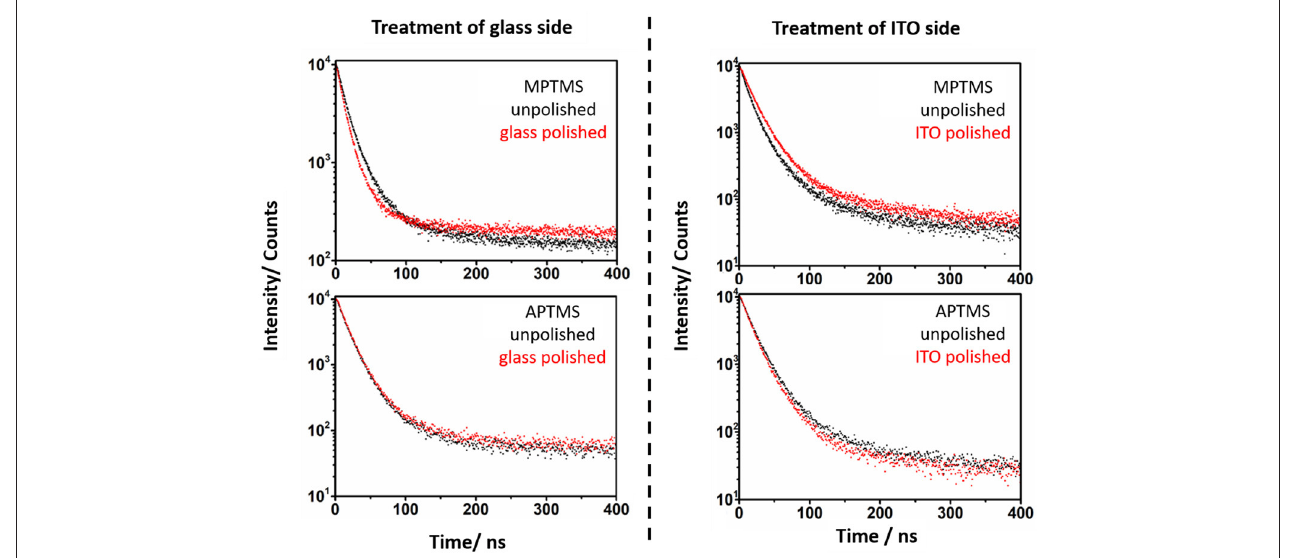
FIGURE 6 | Photoluminescence lifetime spectra of the MPTMS and APTMS based systems before (black) and after polishing (red). The specific side, which is polished is mentioned in the spectra. It is obvious, that the polishing of the glass side of MPTMS based systems decreases the PL lifetime. In contrast to this, a polishing of the ITO side increases the PL lifetime.